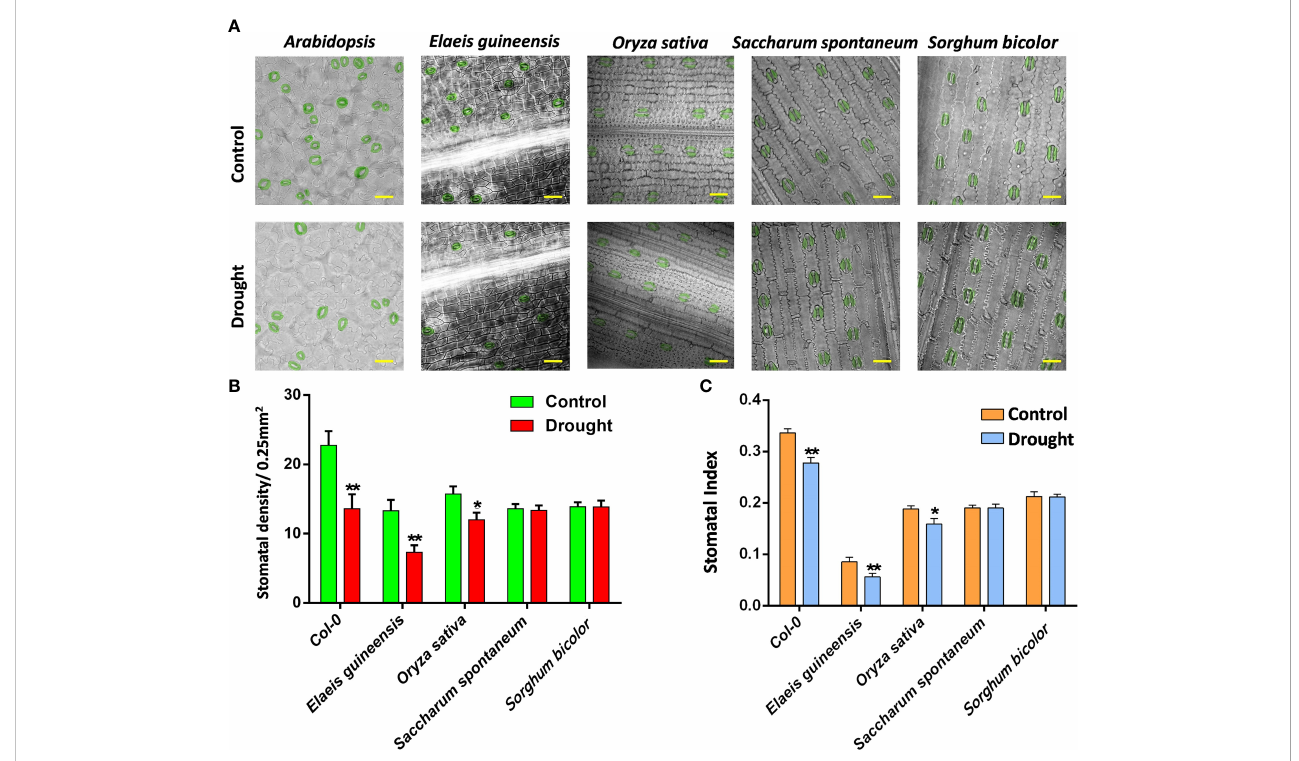
FIGURE 1 (A) The abaxial stomatal pattern of 14 dpg Arabidopsis , two-year-old Elaeis guineesis , 21 dpg Oryza sativa , one-year-old Saccharum spontaneum and one-year-old Sorghum bicolor under control and drought stress. Bar =25 um . (B) The stomatal density of samples from (A) . (C) The stomatal index of samples from (A) . The values are mean ± SEM; n ≥ 20. One-way ANOVA with post hoc Tukey HSD; *, p <0.05; **, p<0.01.